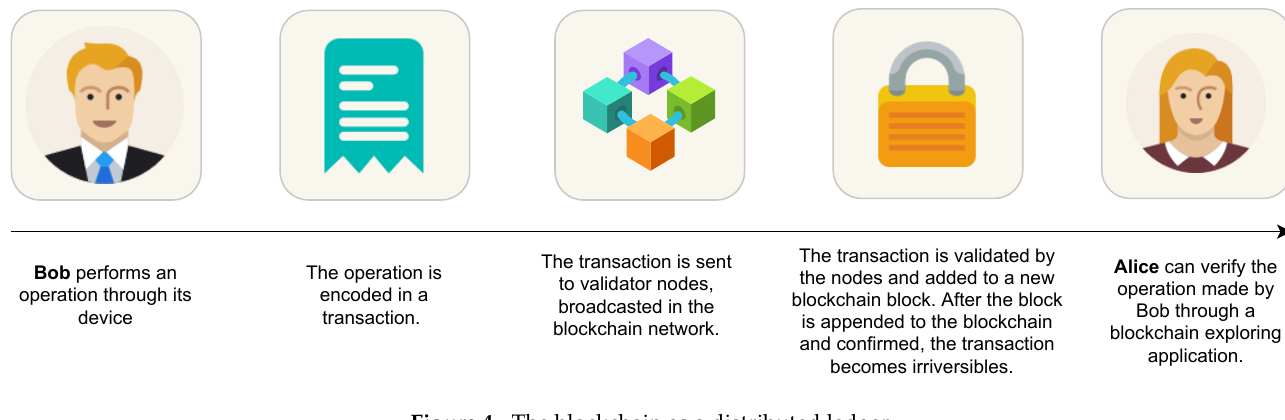
Figure 4. The blockchain as a distributed